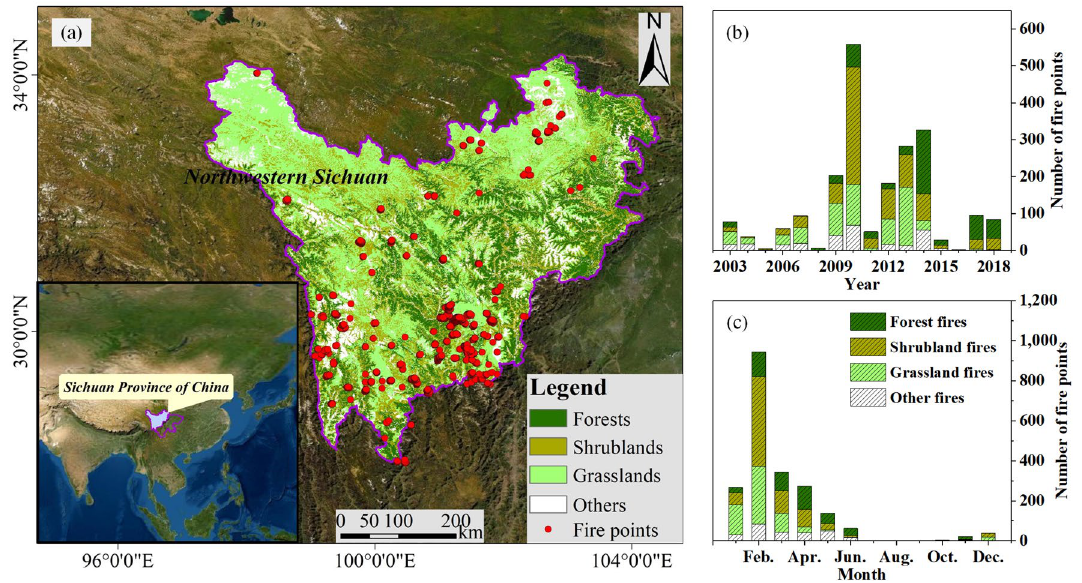
Fig. 1 Location of the study area in northwestern Sichuan ( a ) and yearly ( b ) and monthly ( c ) historical fire points (2003–2018) distribution in forests, shrublands, and grasslands. The background map in ( a ) is from the online map World Imagery (ESRI